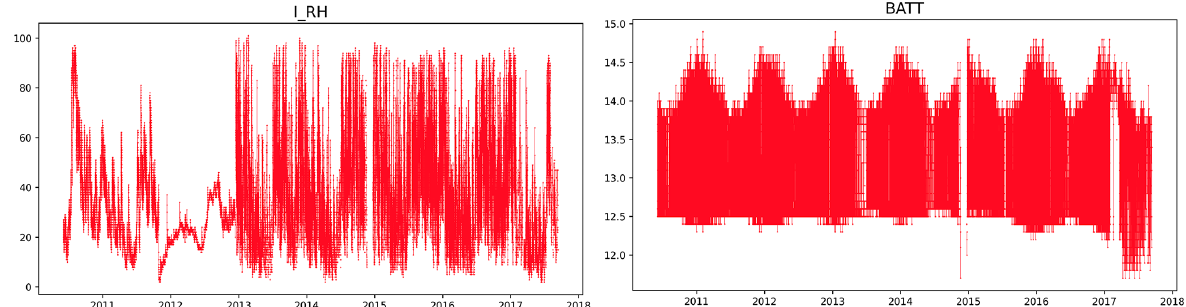
Figure B2. Diagnostic plots that create time series of the data columns are generated. Here, two are presented (titles match variables from Table A4): I_RH is the internal relative humidity, and BATT is the battery voltage. These allow a user to quickly visually understand possible periods where more investigation is necessary. For example, the BATT variable begins to fall around 2017 which demonstrates an issue with the battery (right panel).